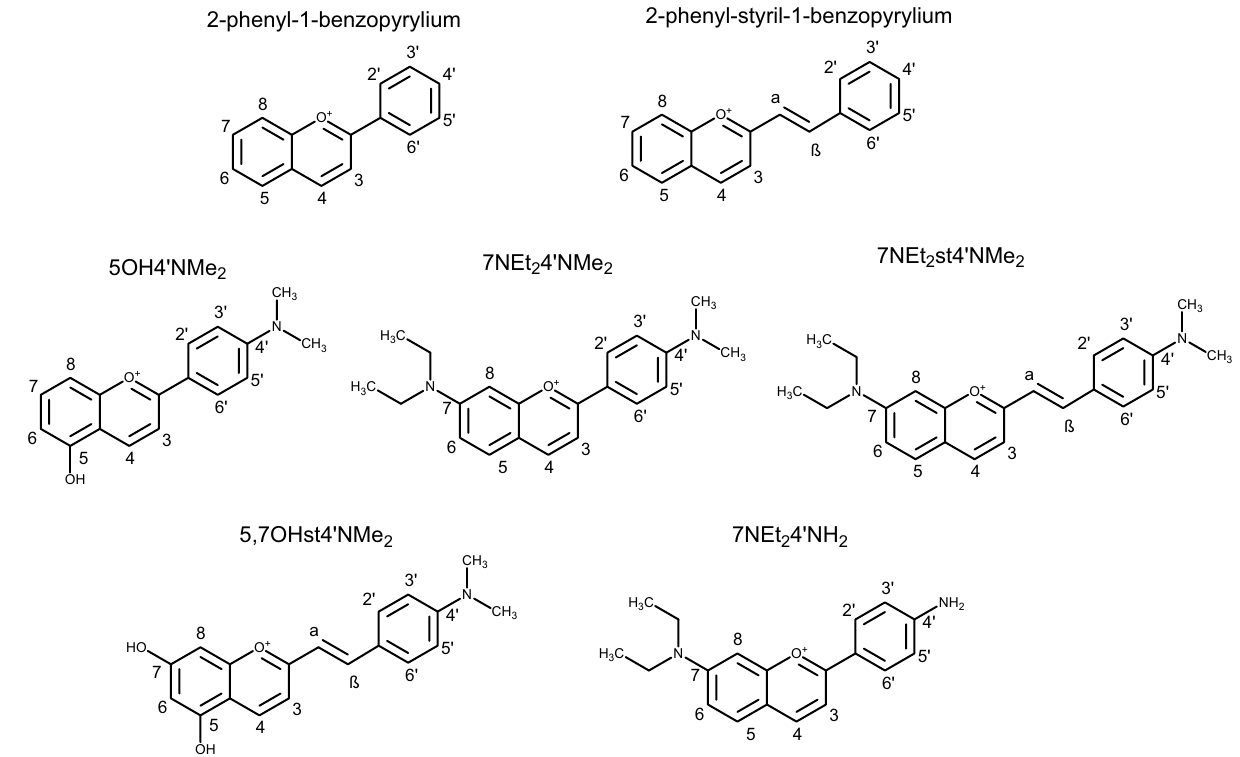
Figure 1. General structure of 2-phenyl-1-benzopyrilium and 2-phenyl-styril-1-benzopyrilium and structure of the amino-based flavylium compounds in their cation form: 5-hydroxy-4 ′ -(dimethylamino)-benzopyrylium (5OH4 ′ NMe 2 ); 7-diethylamino-4 ′ -dimethylamino-benzopyrylium (7NEt 2 4 ′ NMe 2 ); 7-(diethylamino)-2- (4 ′ -dimethylaminostyryl)-benzopyrylium